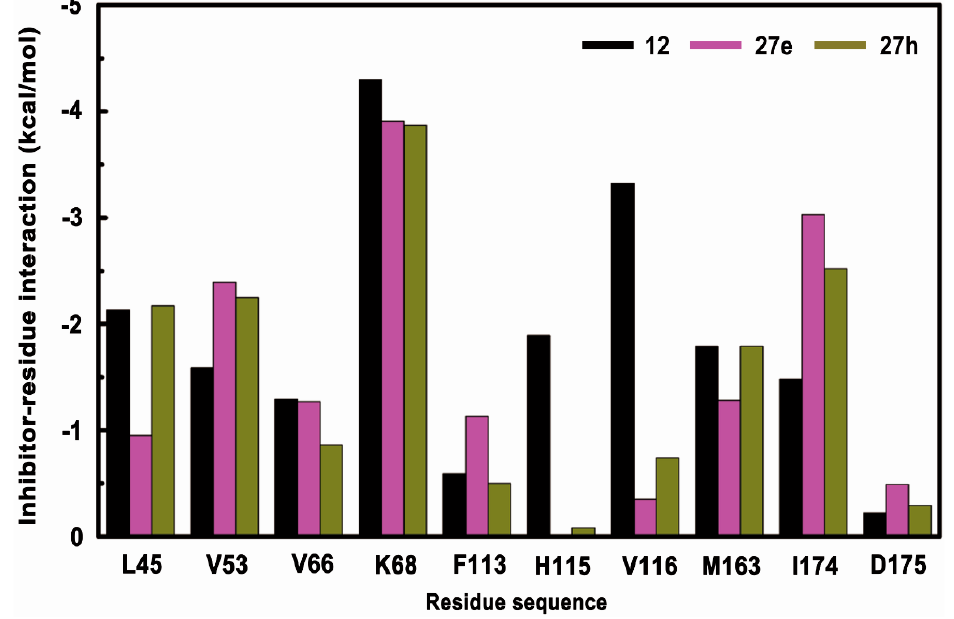
Figure 5. Residue-Based energy decomposition on critical residues for CK2 in complex with compounds 12 (black), 27e (purple) and 27h (brown).